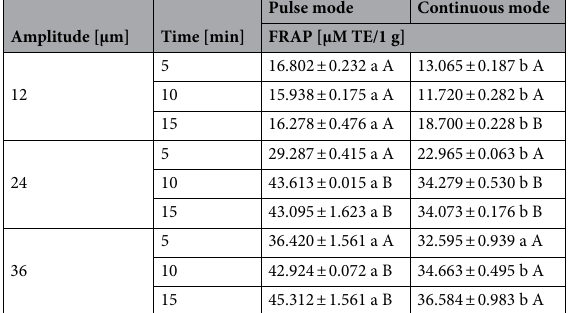
FRAP. Table 2 shows the effect of the treatment type (continuous, pulse) on the antioxidant activity of the Sorbus intermedia extracts determined with the FRAP method. The highest antioxidant activity was detected in extracts obtained in the pulse-mode treatment with the following parameters: 36 µm amplitude and 15 min time. The lowest values were noted in the continuous-mode treatment with the 12 µm amplitude and 5 min time. The difference between the extreme values reached 287%. The amplitude had the greatest effect on the ability to scavenge free radicals. The increase in the vibration amplitude from 12 µm to 36 µm resulted in an increase in the FRAP value from 96 to 196%. Another important determinant of the antioxidant capacity in the Sorbus intermedia extracts was the extraction time. The increase in the sonication time from 5 to 15 min resulted in an increase in the FRAP value from 12 to 48%. The difference in the FRAP values between the pulse and continu- ous modes ranged from 11 to 26%. The processor duty cycle was found to exert a statistically significant effect on the reducing power.